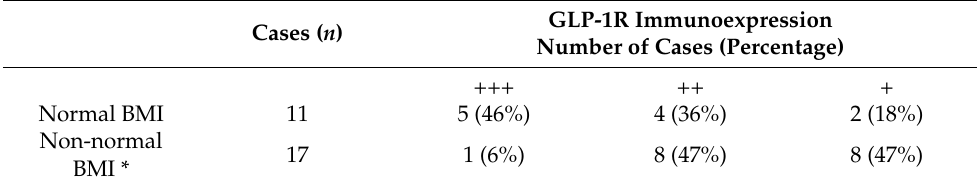
Table 2. Comparison between the semiquantitatively expressed GLP-1R immunoreactivity scores of normal body mass index (BMI) (<25 kg/m 2 ) and non-normal BMI ( ≥ 25 kg/m 2 ) cases in the lateral hypothalamic area. Immunoreactivity score is expressed as follows: +++, >50% of cells exhibit strong immunoexpression; ++, >50% of cells exhibit moderate immunoexpression; +, >50% of cells exhibit weak immunoexpression.